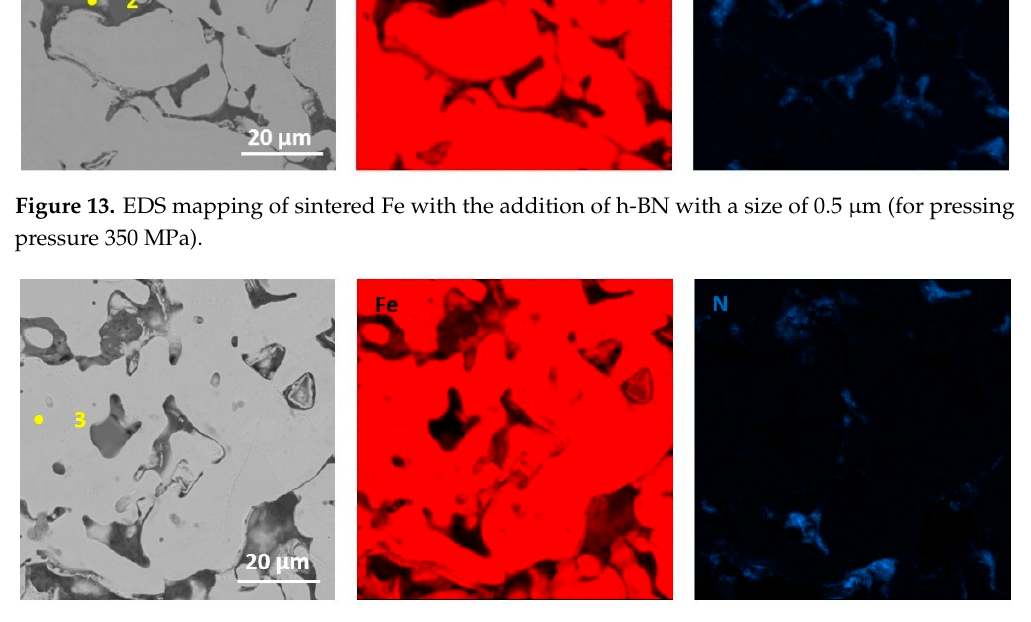
Figure 14. Figure 7 EDS mapping of sintered Fe with the addition of h-BN with a size of 0.5 µ m (for pressing pressure 250 MPa).